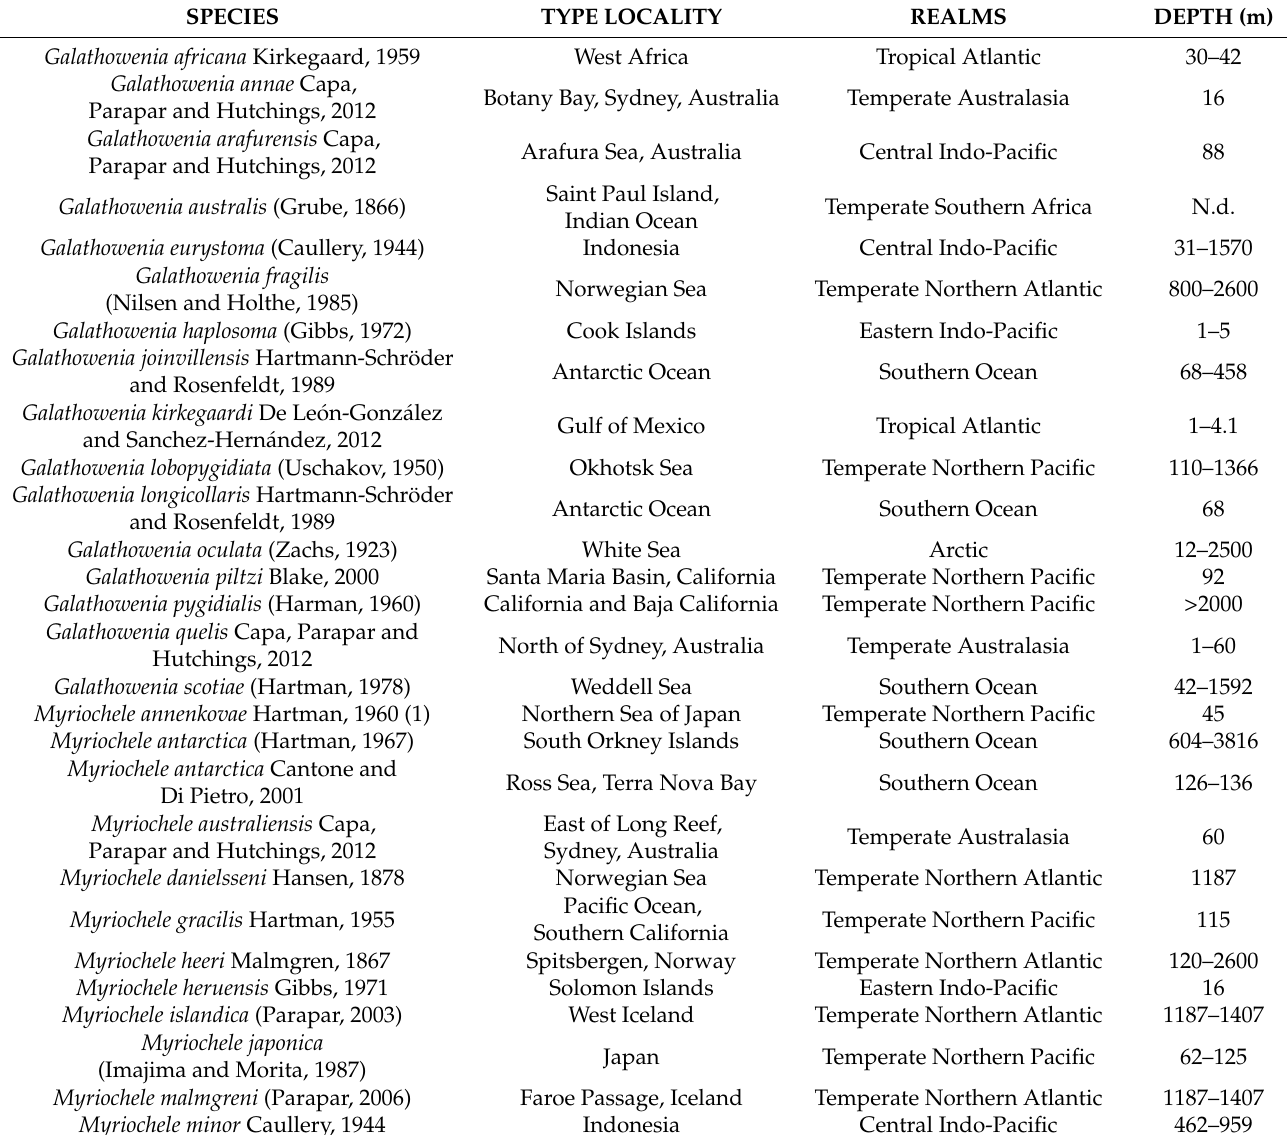
Table A2. Oweniid valid species (partially according to WoRMS), type locality, assigned marine realms (sensu [86]), and depth of type locality. N.d.= No